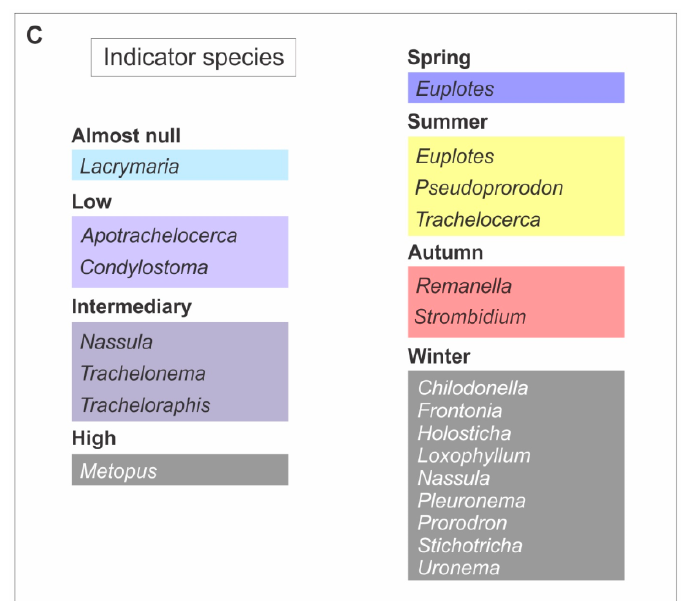
Figure 7. Ordination scatterplots obtained from a nonmetric multidimensional scaling analysis of the benthic ciliate community, using the Bray–Curtis distance index. Stress = 0.0859 for both ordinations. Sampling units identified according to urbanization degree ( A ) and sampling season ( B ). Indicator species present in beaches with different degrees of urbanization and season ( C ).